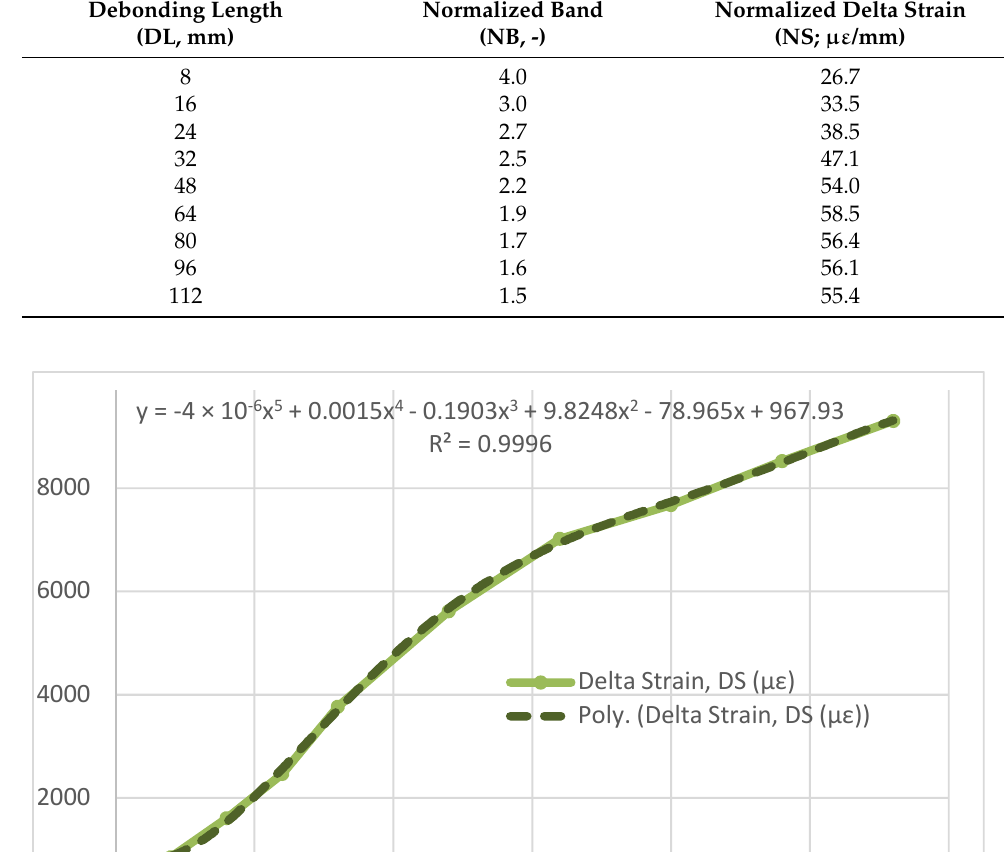
Figure 15. Normalized delta strain as a function of the debonding length, and its polynomial ap- proximation. Moving to the other parameters, a representation of the debonding region effect is illustrated in Figure 16. As can be seen, such a behavior is characterized by two distinct regions, both almost linear. The first one, in the approximated range DL [10; 40], shows that the area whose structural response is influenced by the flaw presence is larger than the flaw itself. In that case, it can be shown the first segment of the curve is parallel to a straight line with an angular coefficient equal to about 2 and is shifted towards the top by an amount of about 20 mm. This, in turn, means that the ratio among the affected region extension and the bonding irregularity size would grow as this latter value approaches zero. Of course, it is expected that a further investigation in that area (i.e., for extremely small values of the damage) would show a further curve segment joining the origin with the curve. In the second zone, approximatively in the interval DL [50; 120], the relationship